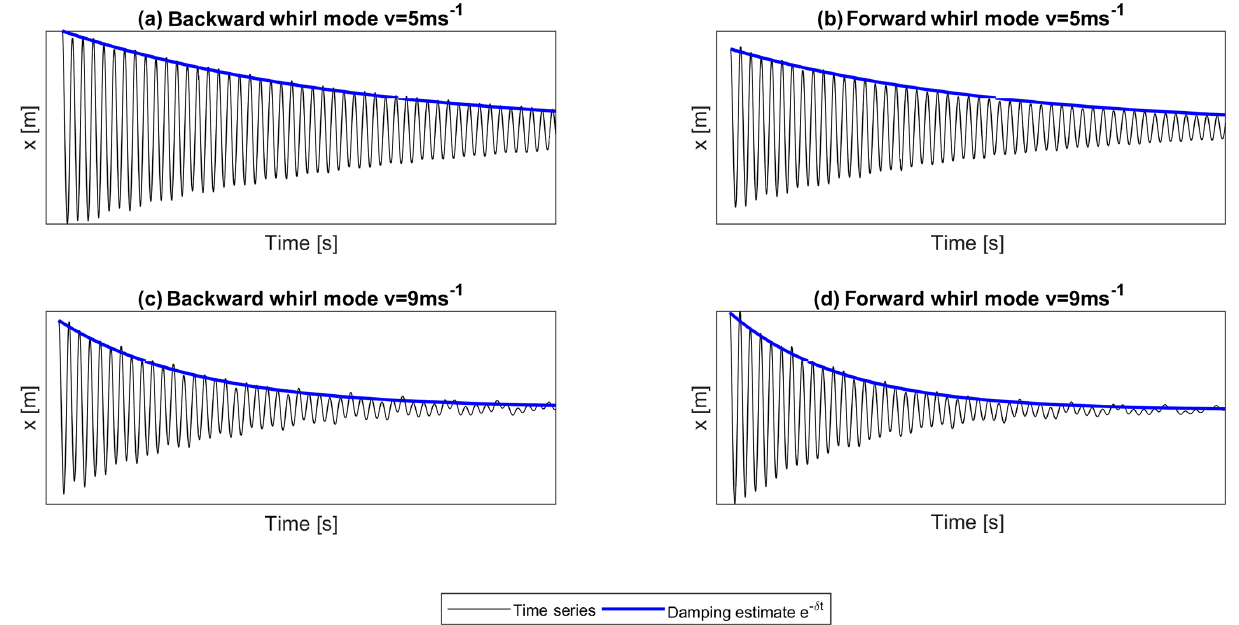
Figure 2. Example of estimated damping for an edgewise displacement time series of the fully flexible upwind configuration at the backward whirl mode (a, c) and the forward whirl mode (b, d) for simulations of 5 and 9ms − 1 wind